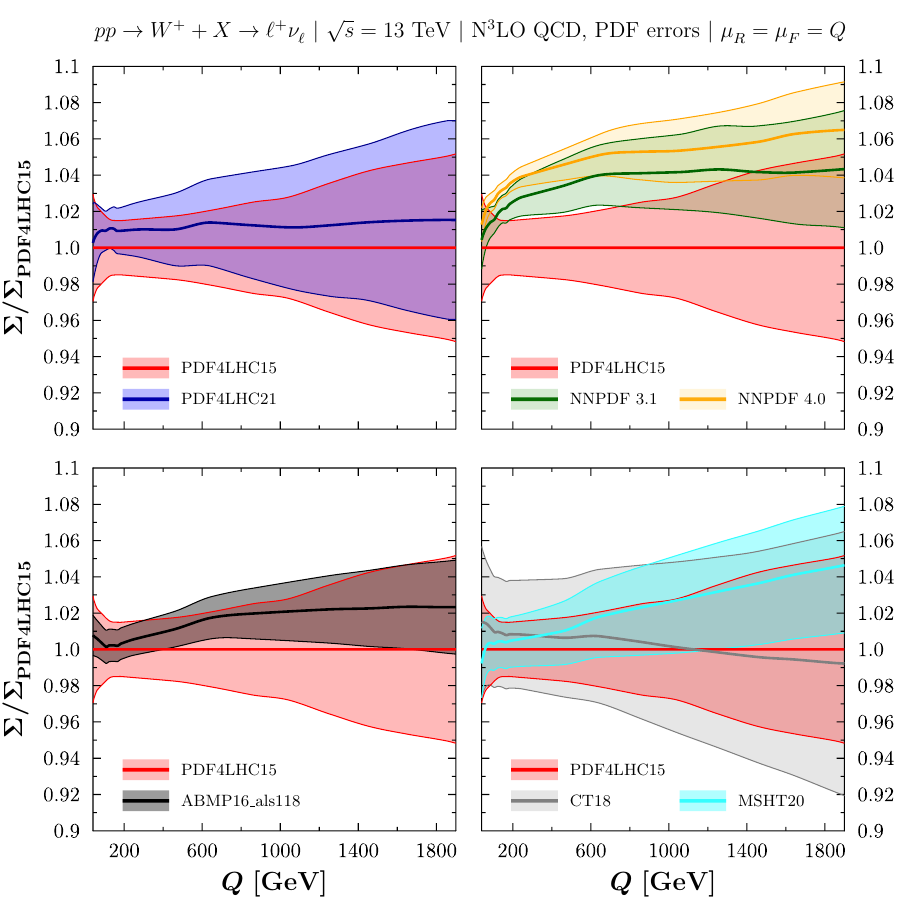
Figure 13 . Same as in figure 12, but for charged-current W + Drell-Yan differential cross